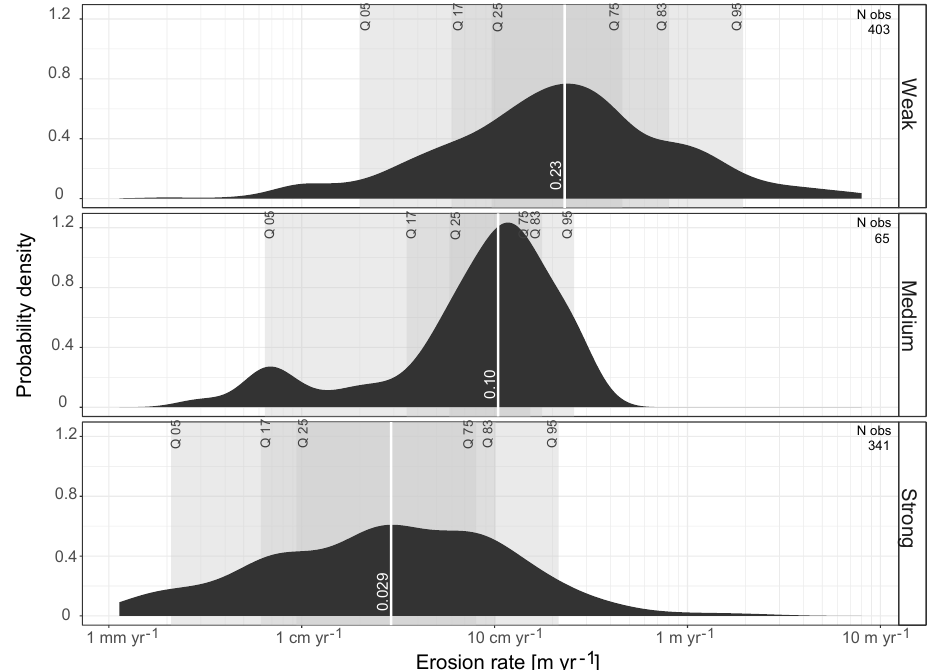
Figure 6. Cliff recession rates differentiated using the Hoek and Brown rock mass strength criterion, which merges lithological descriptions and the fracturing/weathering state of the cliff